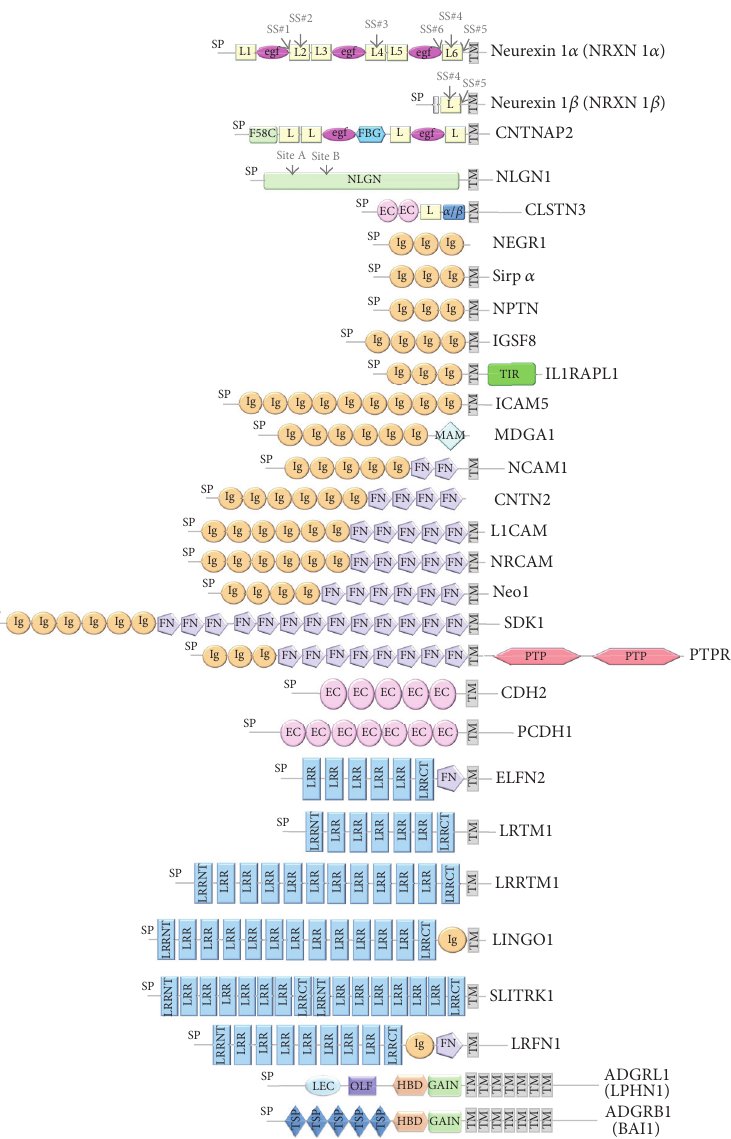
Figure 1: SAMs. Prominent families of SAMs with putative synaptic localization and function are shown. Prototypes used to depict the domain organization are indicated. From top to bottom the following is listed: neurexin 1 𝛼 and neurexin 1 𝛽 (NRXN1 𝛼 and NRXN1 𝛽 ; neurexins); CNTNAP2 (contactin associated protein-like); NLGN1 (neuroligins); CLSTN3 (calsyntenins); NEGR1 (Iglons which include NEGR1, NTM, LSAMP, and OPCML); Sirp 𝛼 (signal regulatory proteins); NPTN (neuroplastin); IGSF8 (immunoglobulin superfamily); IL1RAPL1 (interleukin 1 receptor accessory protein-like); ICAM5 (intercellular adhesion molecules); MDGA1 (MAM domain containing glycosylphosphatidylinositol anchor); NCAM1 (neural cell adhesion molecules); CNTN2 (contactins); L1CAM (L1 cell adhesion molecules); NRCAM (neuronal cell adhesion molecules); Neo1 (neogenin); SDK1 (sidekick cell adhesion molecules); PTPRD (protein tyrosine phosphatasereceptortypesD,F,andS);CDH2(cadherins);PCDH1(protocadherins);ELFN2(extracellularleucinerichrepeatandfibronectin type III domain containing); LRTM1 (leucine rich repeats and transmembrane domains); LRRTM1 (leucine rich repeat transmembrane neuronal); LINGO1 (leucine rich repeat and Ig domain containing); SLITRK1 (SLIT and NTRK-like family member); LRFN1 (leucine rich repeat and fibronectin type III domain containing); ADGRL1 (adhesion G protein-coupled receptor type L; previously known as latrophilins); ADGRB1 (adhesion G protein-coupled receptor type B, previously known as brain-specific angiogenesis inhibitor). Several large polymorphic families including the ephrin receptors, integrins, and plexins are not shown. The domain abbreviations used in the text are for laminin G or laminin G/neurexin/sex hormone binding globulin or LNS domains (L); epidermal growth factor repeat (EGF); coagulation factor 5/8 type C (F58C); fibrinogen-like (FBG); extracellular cadherin (EC); alpha/beta ( 𝛼 / 𝛽 ); immunoglobulin (Ig); Toll/Il-1 receptor homology (TIR); meprin, A-5 protein, receptor protein tyrosine phosphatase mu (MAM); fibronectin type 3 (FN), protein tyrosine phosphatase (PTP); leucine rich repeat (LRR), N-terminal leucine rich repeat (LRRNT); C-terminal leucine rich repeat (LRRCT); galactose binding lectin domain (LEC); olfactomedin-like domain (OLF); hormone binding domain (HBD); GPCR-autoproteolysis inducing (GAIN); thrombospondin (TSP). Other abbreviations are signal peptide (SP) and transmembrane segment (TM). Alternative splice insert sites are indicted for the SAMs NRXN1 𝛼 , NRXN1 𝛽 , and NLGN1, as they are referred to in the